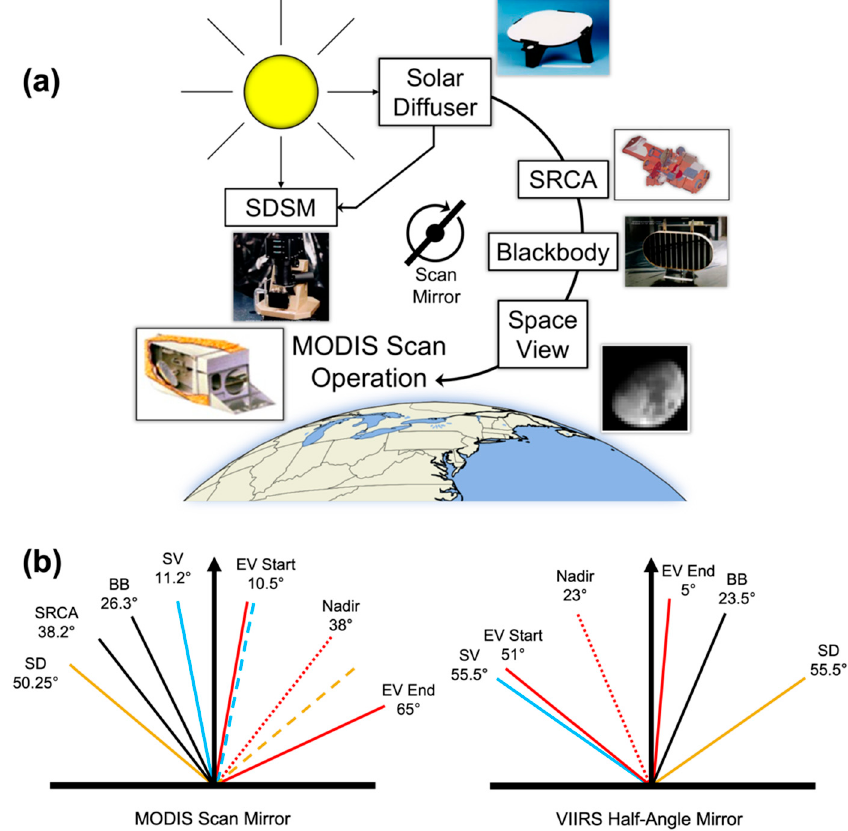
Figure 1. ( a ) Schematic of MODIS scan operation and instrument OBCs. The VIIRS instrument has a similar configuration. ( b ) AOI on the scan mirror (MODIS, left) and half-angle mirror (VIIRS, right) for the OBCs and the EV. The dashed lines show the projection of the MODIS AOI onto the EV AOI when computing the RVS.